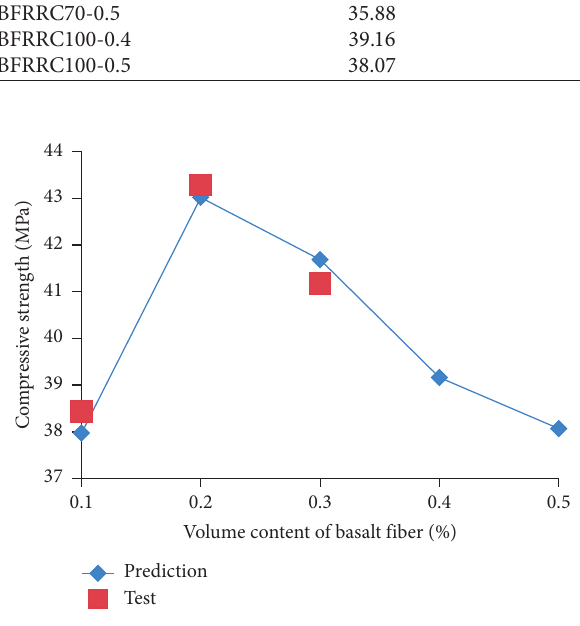
Figure 9: Variation of compressive strength of BFRRC.